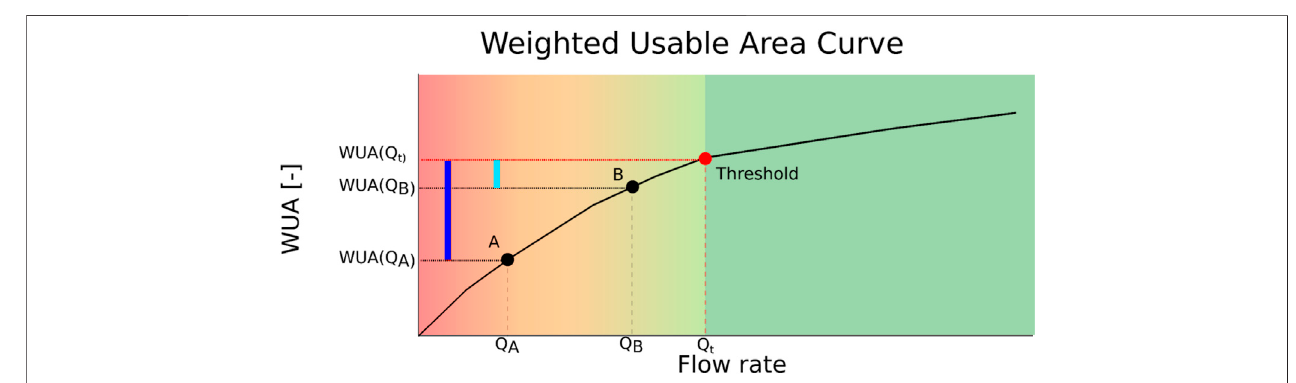
FIGURE2| ExampleofaWeightedUsableAreacurve modeledwiththePHABSIM software (Bloesch etal.,2005;Milhous etal.,1984;Maddock,1999).Thewell- being ofthe fi shisshownbythecolorofthebackground,greenbeinggoodandred isbad.Itisusedtocomputethethreealternativesof fi shhabitatsuitabilityindicators Eco V 1 , Eco V 2 and Eco V 3